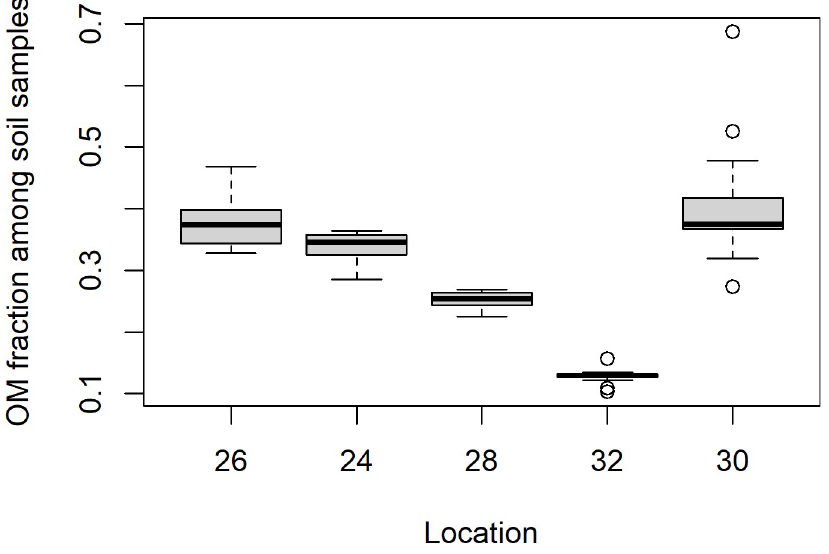
Fig 5. Boxplot of organic matter (OM) fraction of soil samples among localities from Mining hill.